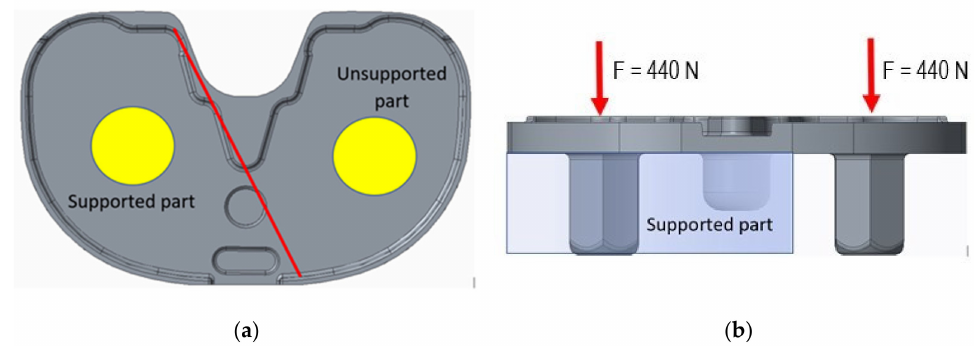
Figure 11. Loading conditions of tibial baseplate in ( a ) top view and ( b ) side